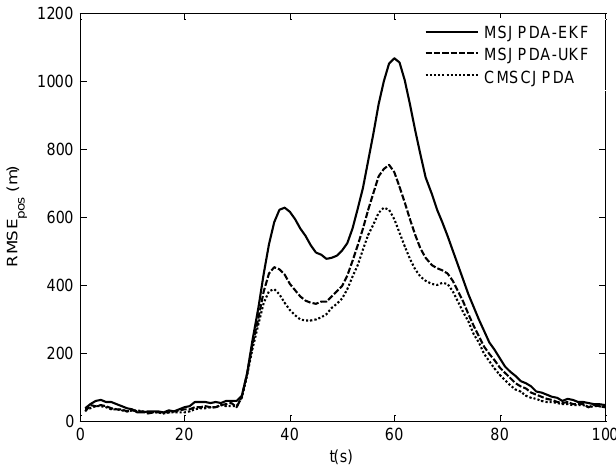
Figure 7. Root mean square position error of target 1.